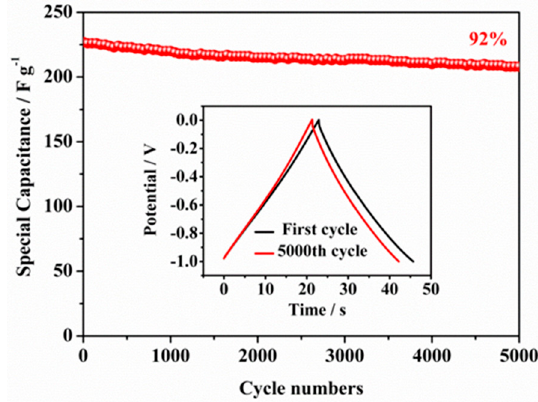
Figure 4. Cycling stability of KAC-800 at the current density of 10 A g − 1 for 5000 cycles. The inset shows the GCD lines of the first and 5000th cycles.